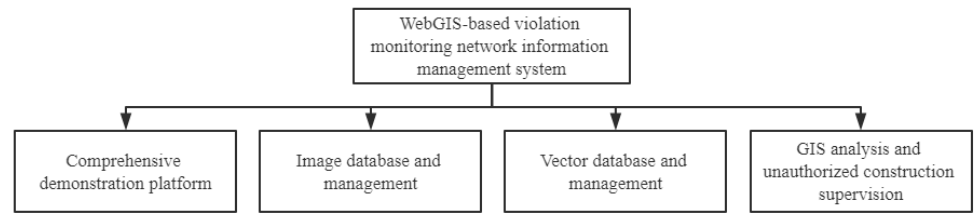
Figure 8. Functional modules of designed system.